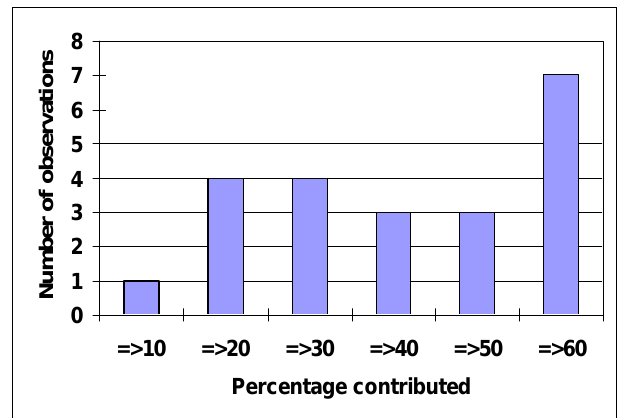
Figure 1: Size of syndicated investments (excluding the three largest investments)